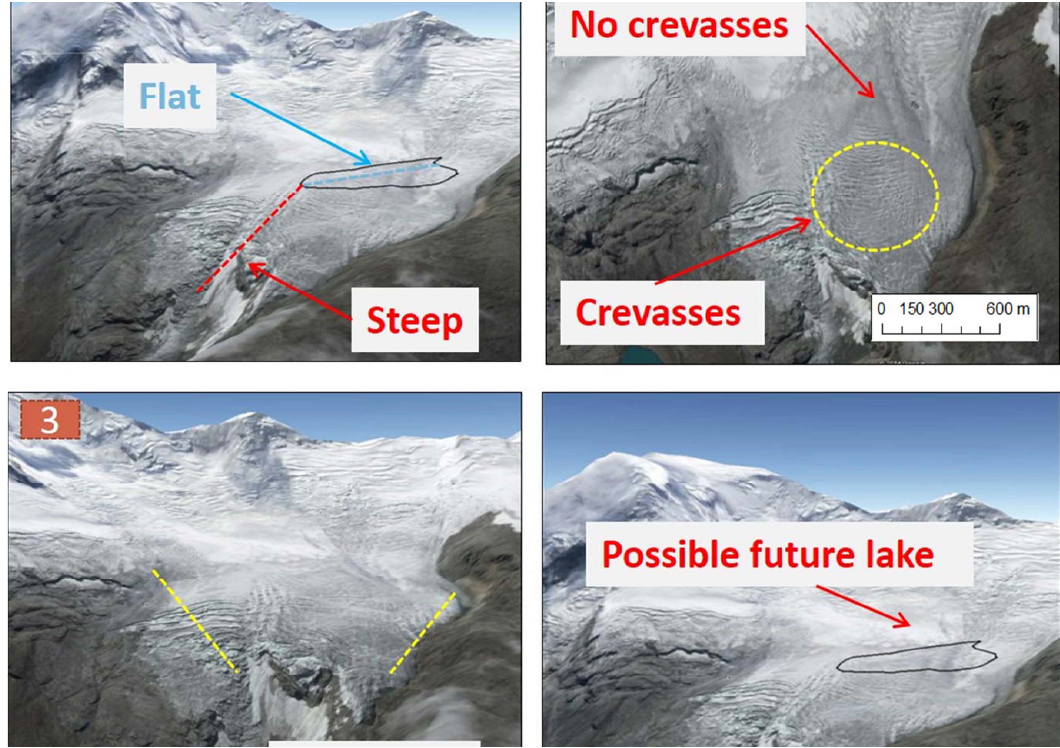
Figure 3. Morphological criteria (numbers 1, 2, 3) that indicate the existence of glacier-bed overdeepenings: Glaciar Rajupaquinan, Cordillera Blanca. Images from Google Earth.